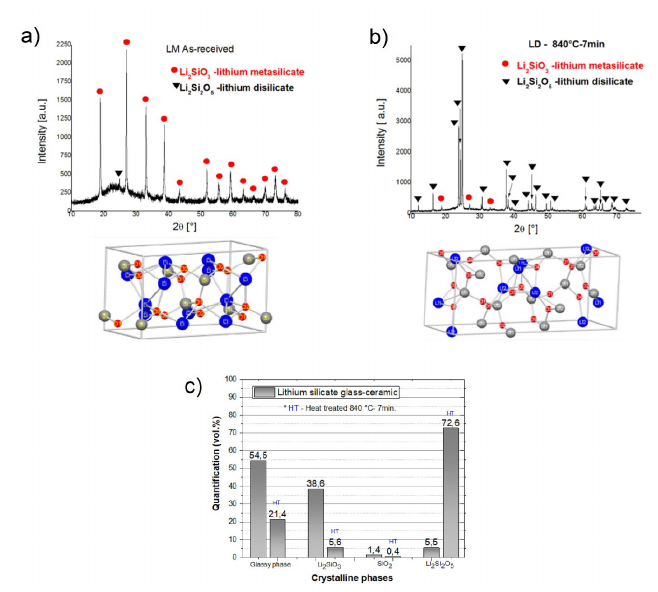
SiO unit cell b) after heat treatment and Li 2 3